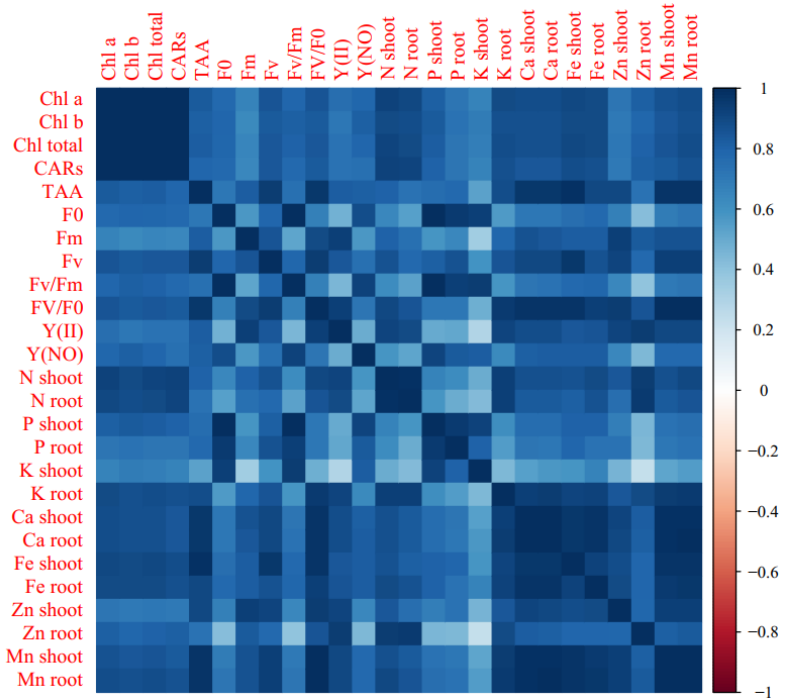
Figure 3. Heat map of Pearson’s correlation analysis for the response of arbuscular mycorrhiza fungi (AMF) inoculation along with seaweed extracts (SWE) foliar application to Lactuca sativa L. Heat map representing chlorophyll a (Chl a ), chlorophyll b (Chl b ), total chlorophyll (Chl total), carote- noids (CARs), total antioxidant activity (TAA), F 0 , F v , F m , F v / F m , F v / F 0 , Y(NO), Y(II), and N, P, K, Ca, Fe, Zn, Ca concentrations in shoots and roots.